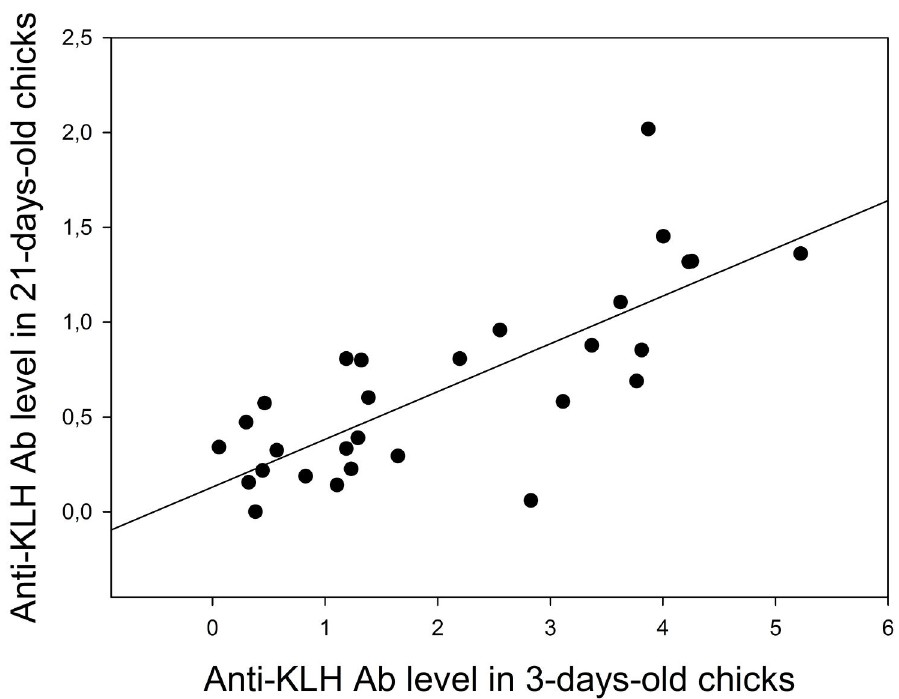
Figure 3. Positive relationship between anti-KLH Ab levels in 3- and 21-day-old chicks from immunized biological